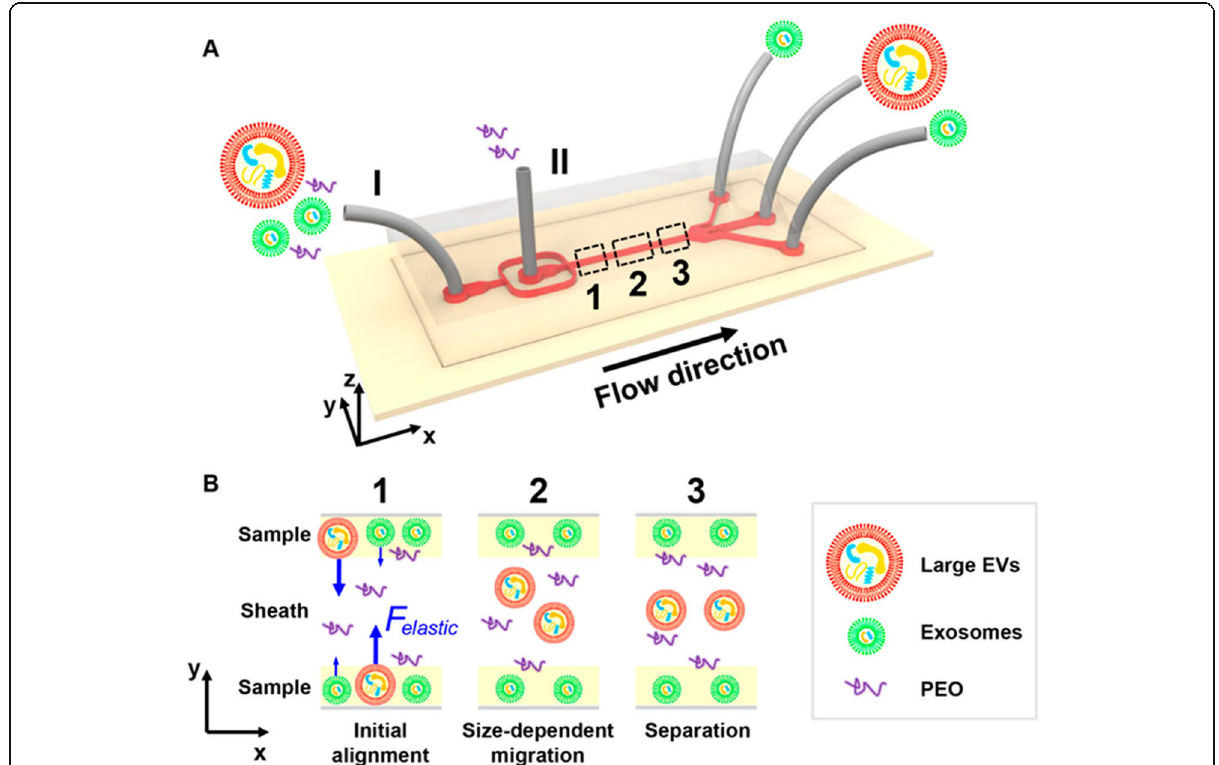
Fig. 1 The microfluidic chip for exosome separation from large EVs [75]. Copyright© 2017, American Chemical